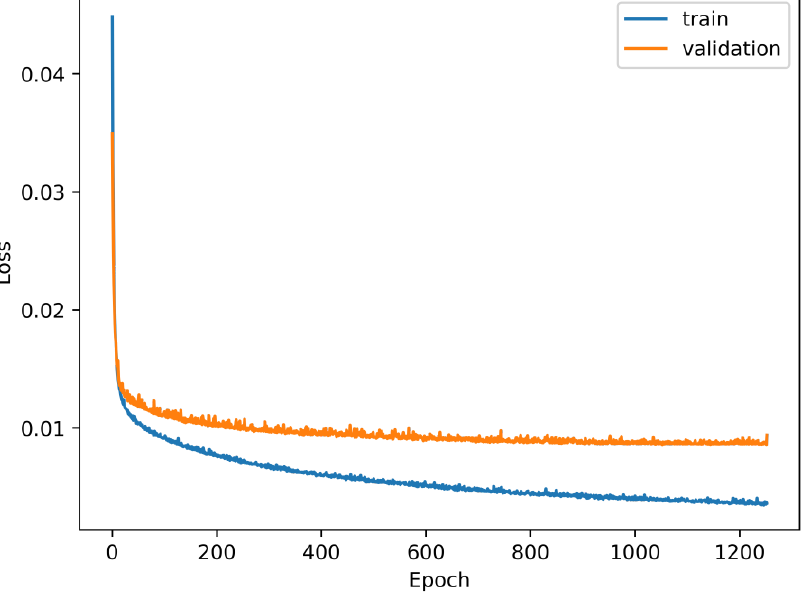
Figure 7. A model raining and validation process.